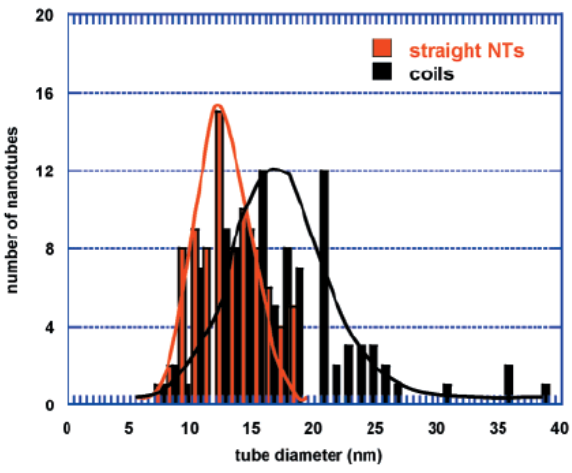
Figure 10. Comparison of tube diameter distributions for straight nanotubes and spirals. Reproduced from [25] with